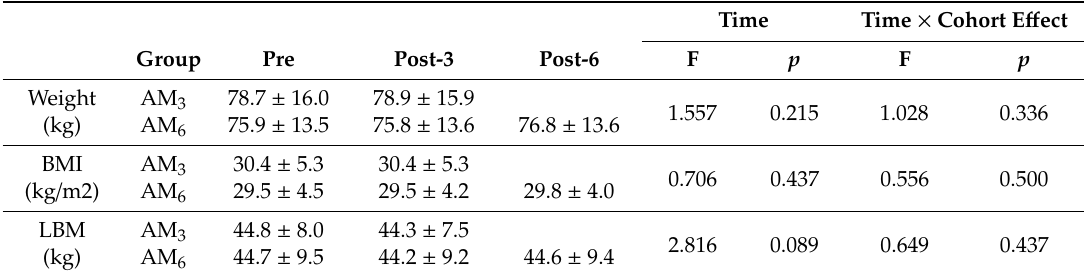
Table 4. Body composition variables before the exercise program and after follow